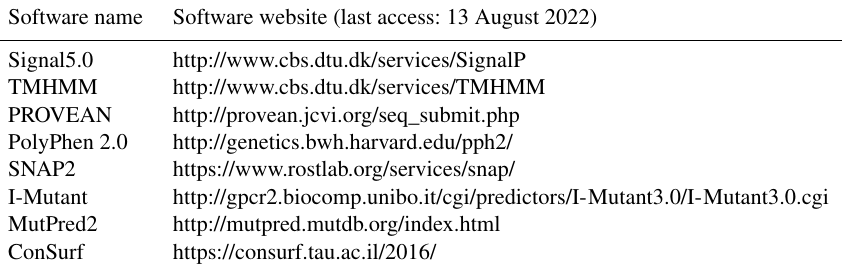
Table 2. MLPH gene sequence bioinformatics software packages and their